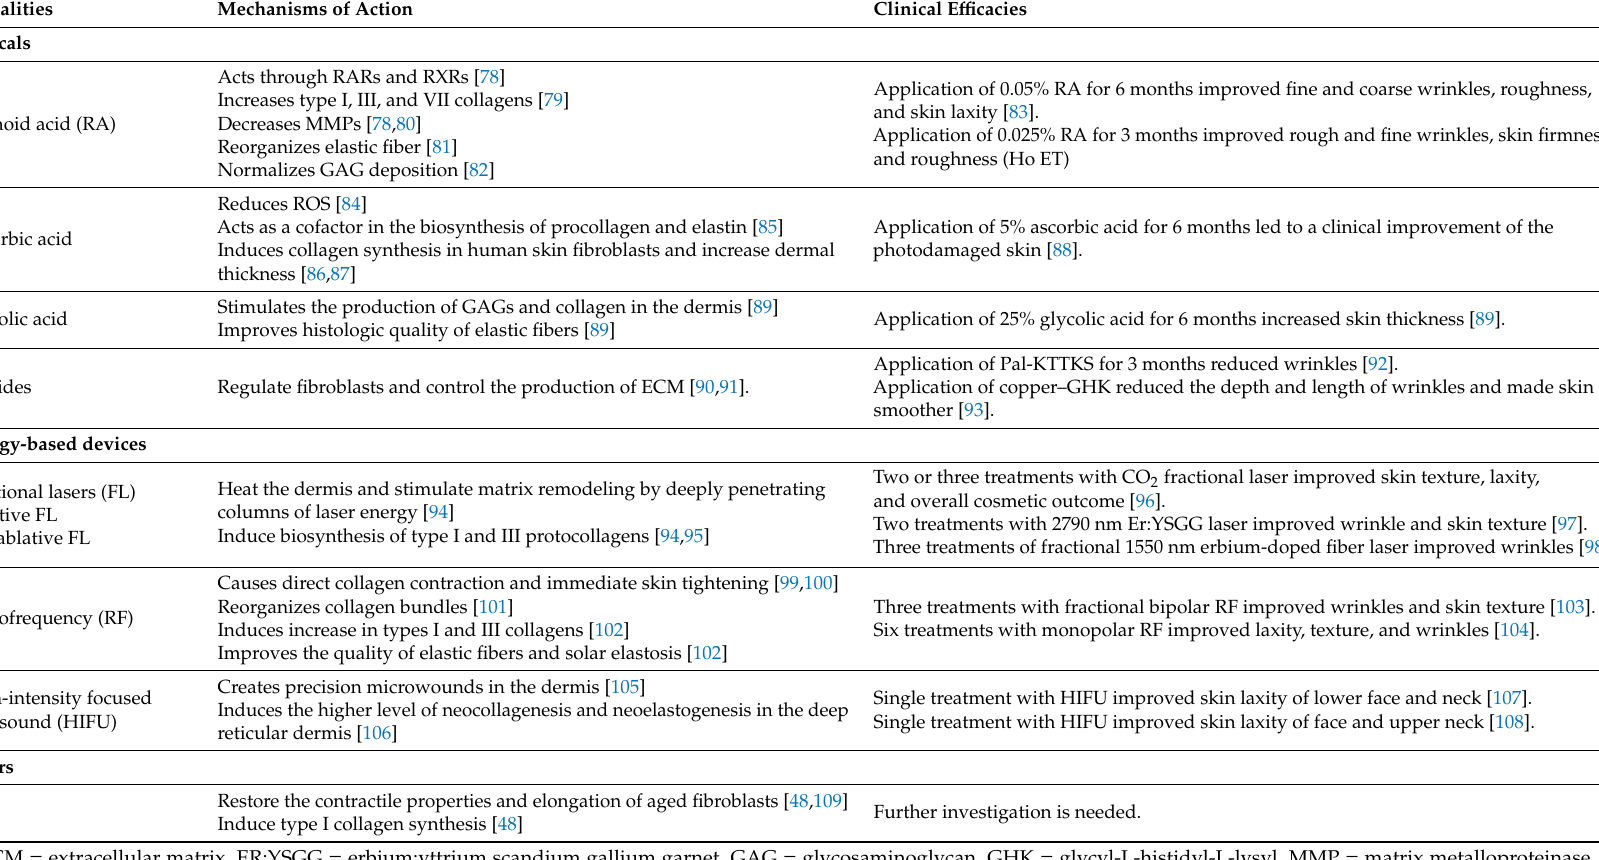
Table 2. Mechanisms of action and clinical e ffi cacies of representative antiaging